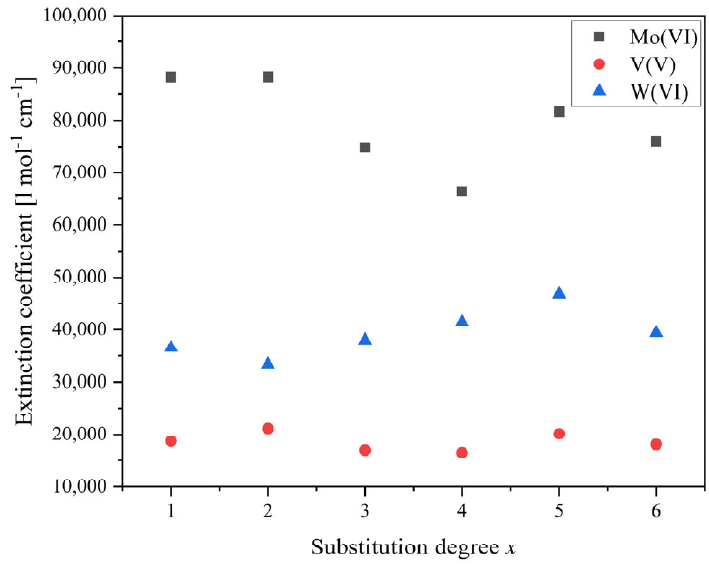
Figure 10. Plot of the extinction coefficients versus substitution degree.